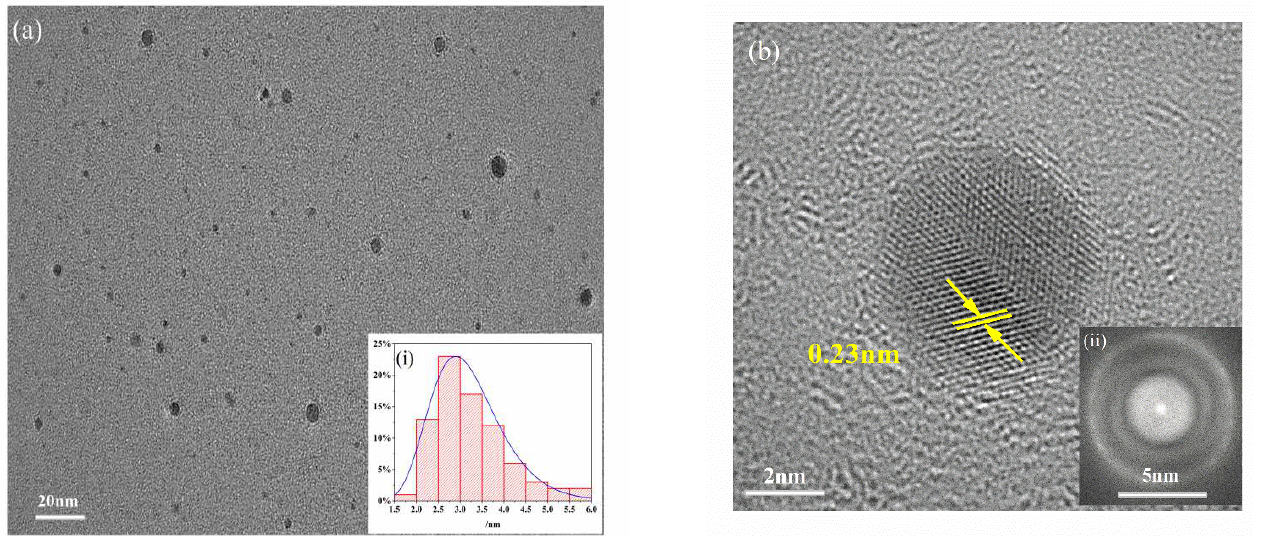
Figure 1. TEM ( a ) and HRTEM images ( b ) of MPA-InP/ZnS QDs (inset: particle size distribution ( i ) and CCD image of MPA-InP/ZnS QDs ( ii )). TEM: transmission electron microscopy, HRTEM: high resolution transmission electron microscope, MPA-InP/ZnS QDs : mercaptopropionic acid capped InP/ZnS quantum dots, CCD: charge couple device.